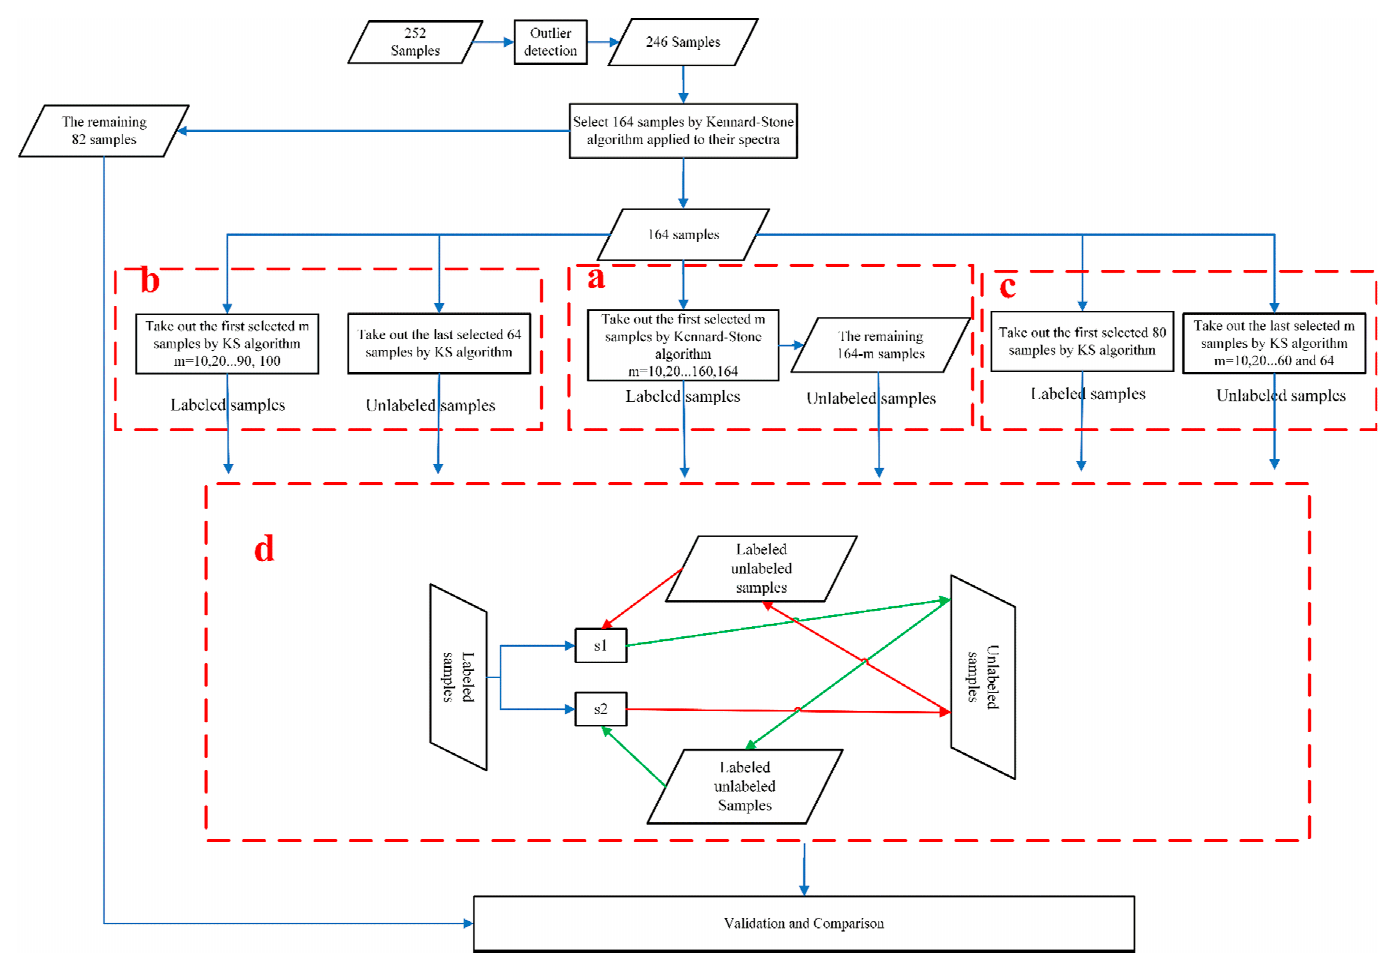
Figure 1. Flow chart for model calibration and validation: ( a ) the setup for sensitivity to the percentage of labeled samples; ( b ) the setup for the sensitivity to the number of labeled samples; ( c ) the setup for the sensitivity to the number of unlabeled samples; and ( d ) the co-training process in semi-supervised regression (SSR).